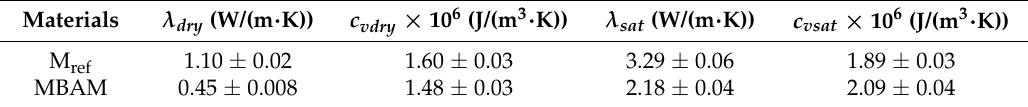
Table 9. Thermal properties.